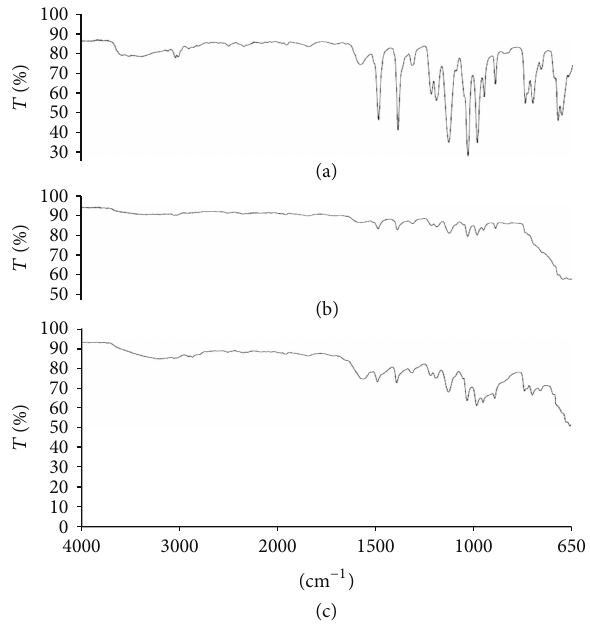
Figure 11: FTIR-ATR analysis for observing chemical adsorption of TiO 2 on the membrane surface: (a) new membrane without TiO 2 coating, (b) before ultrafiltration with TiO 2 coating, and (c) after ultrafiltration with TiO 2 coating.